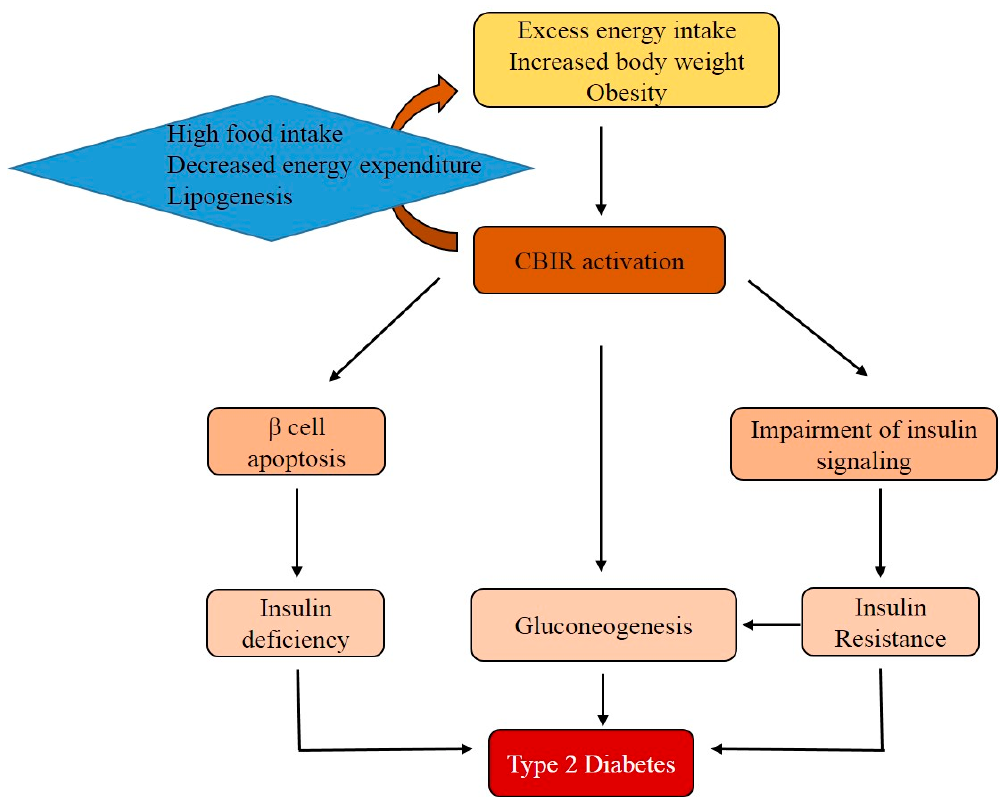
Figure 4. The role of the CB1R in the development of type 2 diabetes mellitus (T2DM). Excess food intake and obesity activates CB1R. The activation of CB1R is associated with gluconeogenesis and insulin resistance. Additionally, CB1R indirectly contributes to β -cell apoptosis. Finally, insulin resistance and relative insulin deficiency both contribute to the development of T2DM.